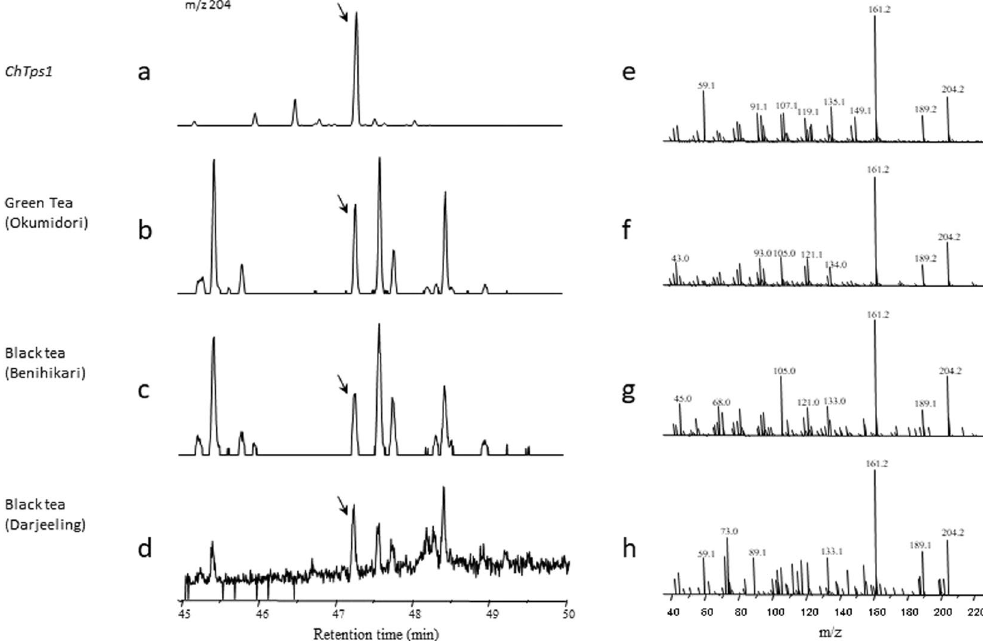
Figure 5. GC-MS analysis of the volatile compounds extracted from teas. Extracted ion chromatogram of m/z 204 (left) and MS of peaks detected at 47.3 min (right) were obtained by GC-MS analysis of green tea and black tea. Extracted samples were as follows: ChTps1 clone ( a and e ) green tea (Okumidori) ( b and f ) Japanese black tea (Benihikari) ( c and g ) Indian black tea (Darjeeling) ( d and h ). Arrows indicate the peak at 47.3 min, where ChTPS1 main product valerianol was detected in ( a